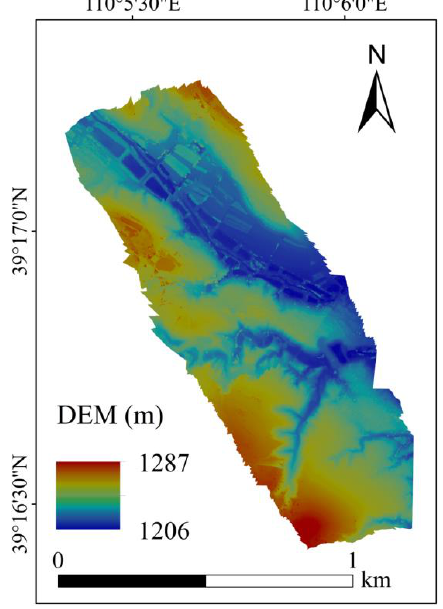
Figure 9. The DEM generated by UAV in the study area.